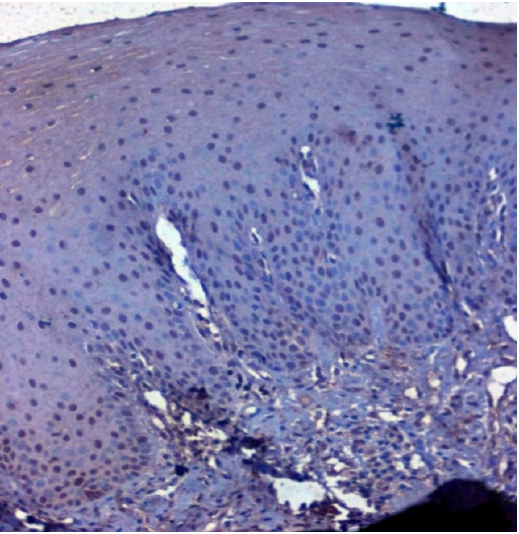
Figure 4. IHC for CA 1 in normal samples (under 20× magnification).